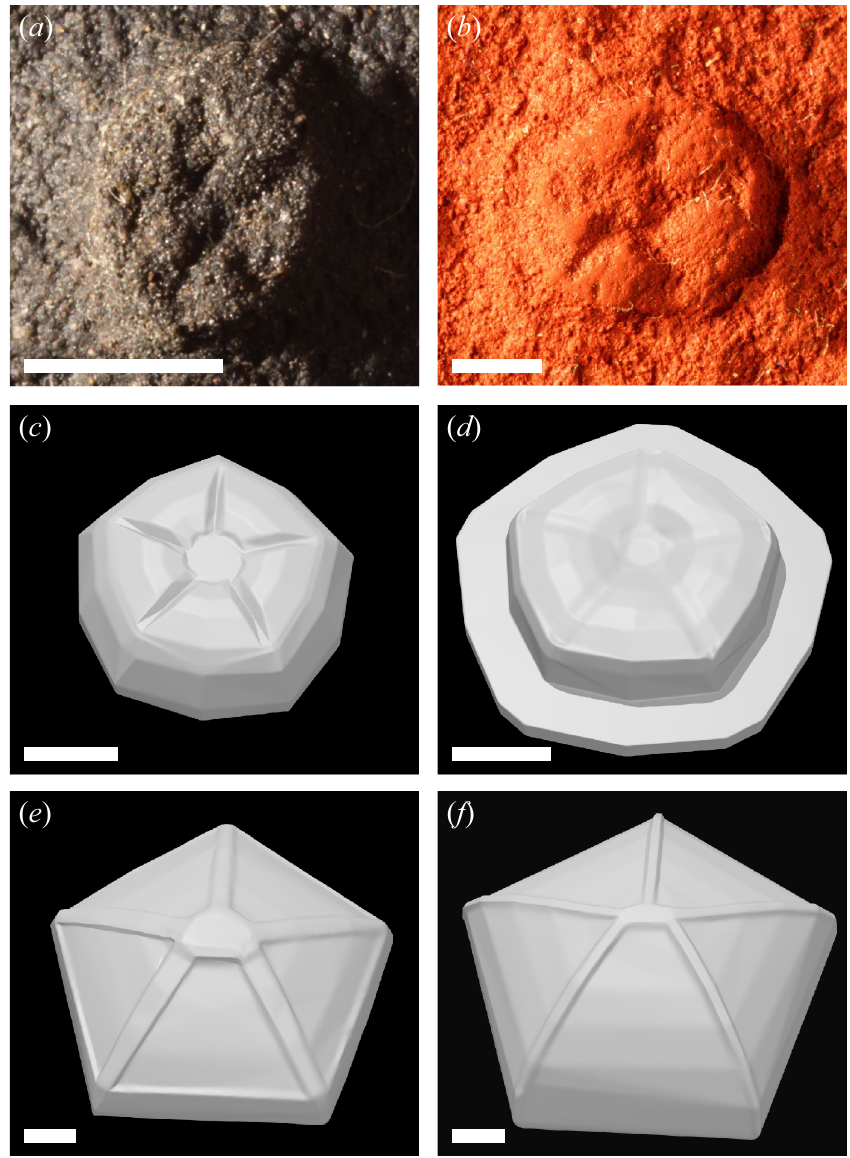
Figure 1. ( a ) Cast of Arkarua adami (SAMP P 40310) from Devil’s Peak, Flinders Ranges, South Australia. ( b ) Cast of Arkarua adami (SAM P 26768) from the Chace Range, Flinders Ranges, South Australia. ( c ) Three-dimensional digital model of Arkarua morphotype 1. ( d ) Three-dimensional digital model of Arkarua morphotype 2. ( e ) Three-dimensional digital model of Cambraster . ( f ) Three-dimensional digital model of Stromatocystites . Scale bars = 2